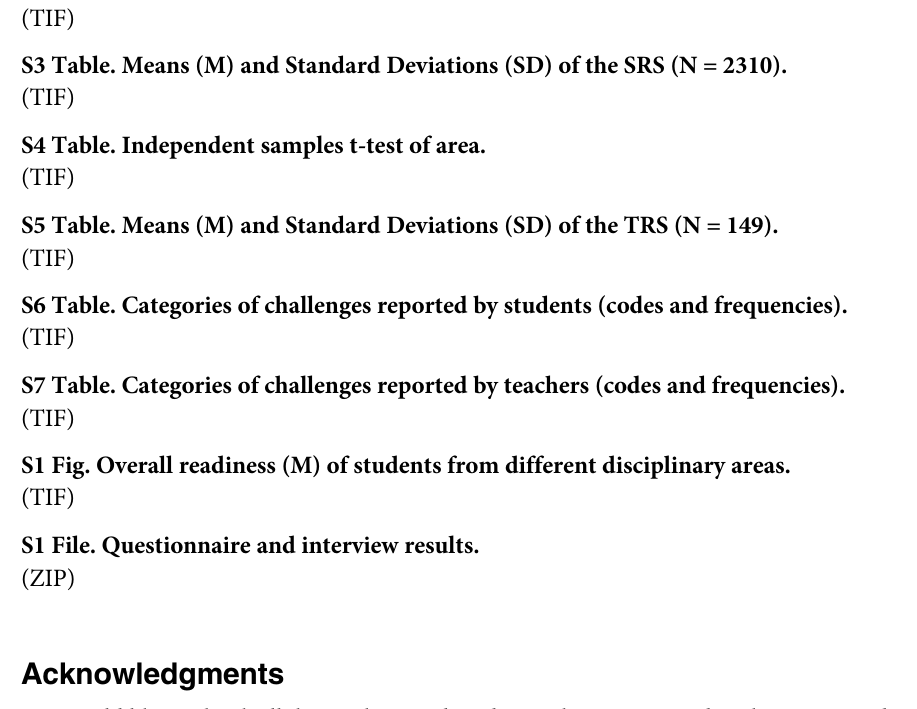
S2 Table. Demographics for teacher respondents. S3 Table. Means (M) and Standard Deviations (SD) of the SRS (N = 2310). S4 Table. Independent samples t-test of area. S5 Table. Means (M) and Standard Deviations (SD) of the TRS (N = 149). S6 Table. Categories of challenges reported by students (codes and frequencies). S7 Table. Categories of challenges reported by teachers (codes and frequencies). S1 Fig. Overall readiness (M) of students from different disciplinary